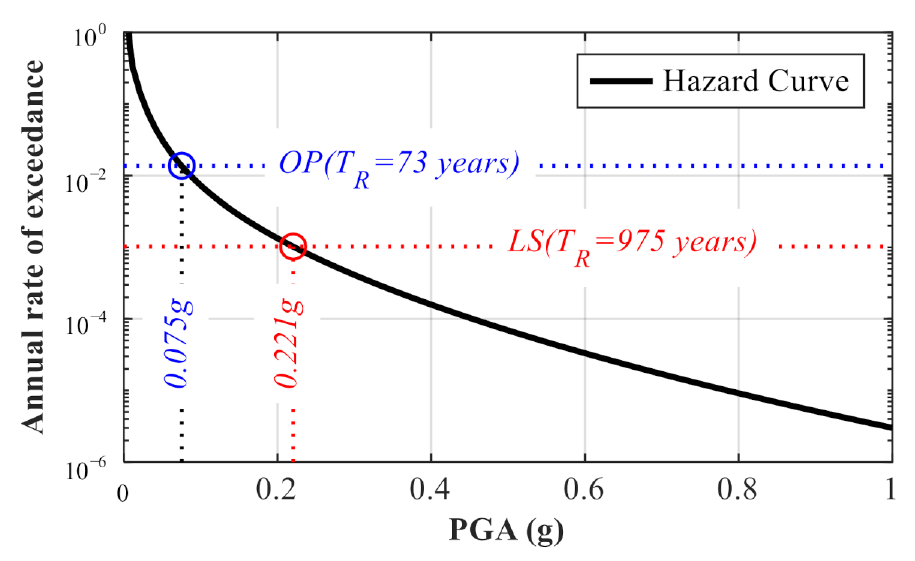
Figure 20. Average seismic hazard curve for the site with different earthquake levels.